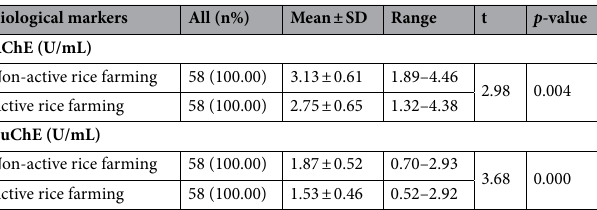
Table 3. Cholinesterase activities observed during non-active and active rice farming periods.